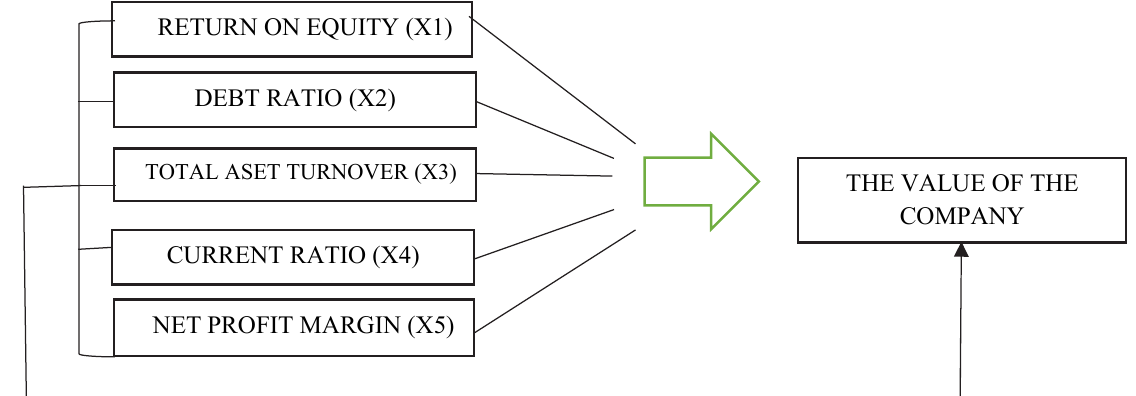
Fig. 1. Theoretical Framework (Source: Author